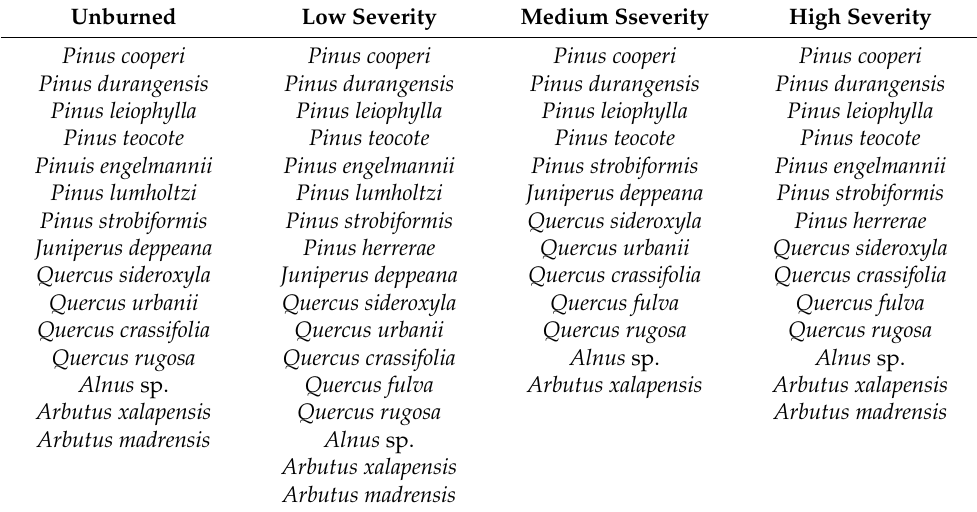
Table 2. Tree species found by fire severity level.